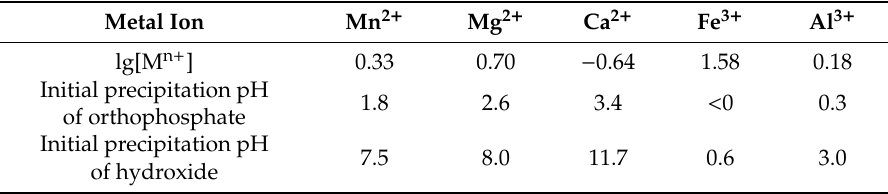
Table 4. Critical pH of each phosphate and hydroxide precipitation in the reaction system.